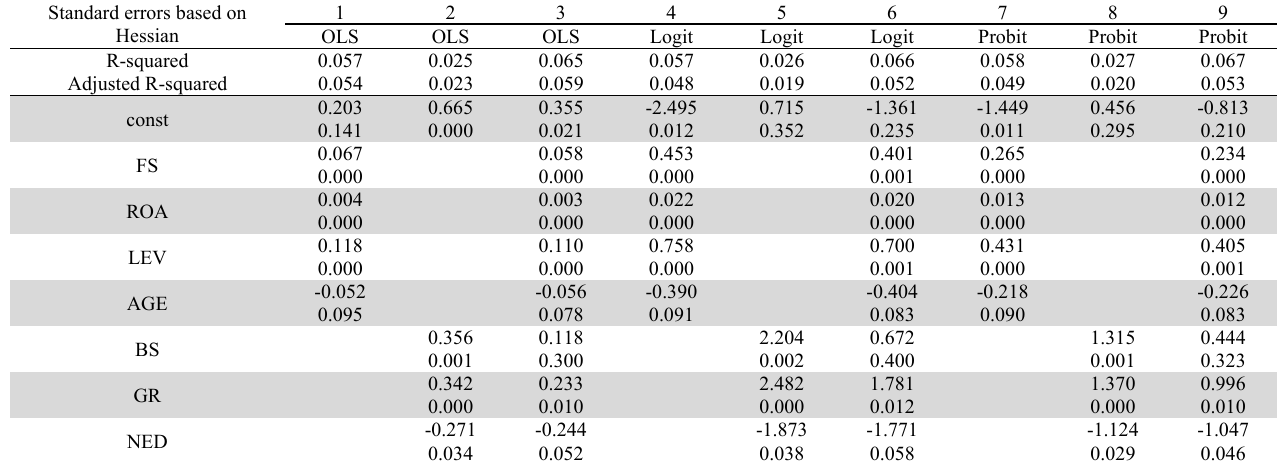
Logit and Probit Regression Analysis Standard errors based on